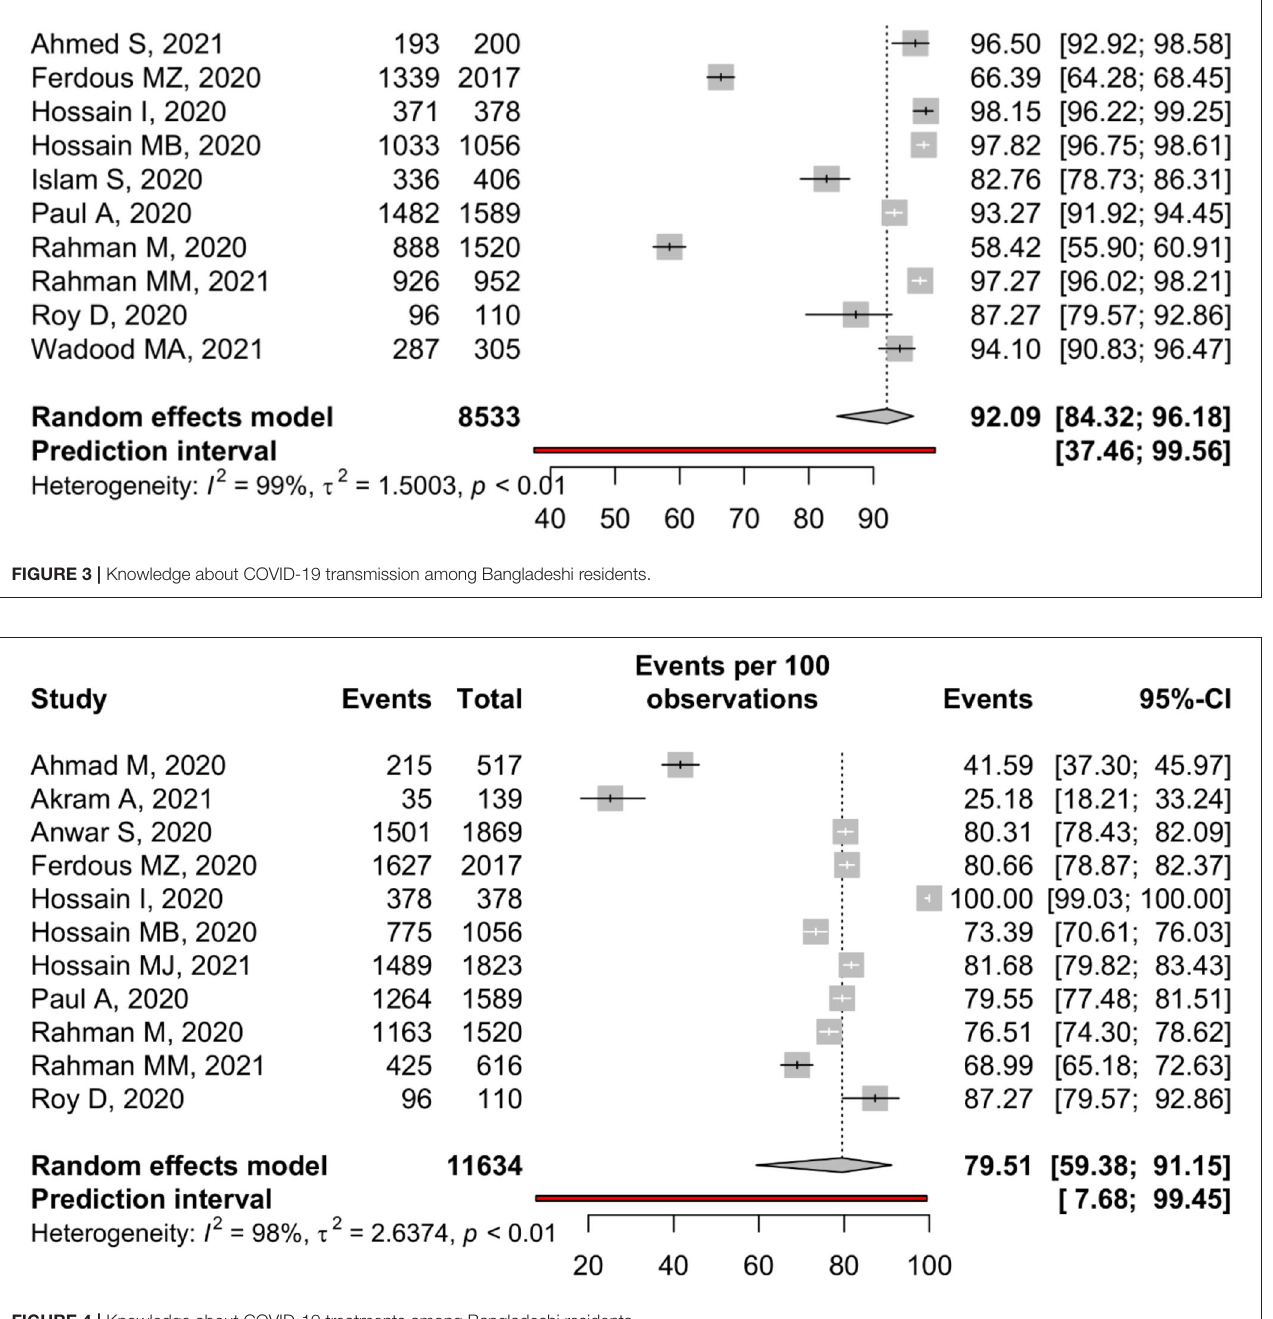
FIGURE 4 | Knowledge about COVID-19 treatments among Bangladeshi